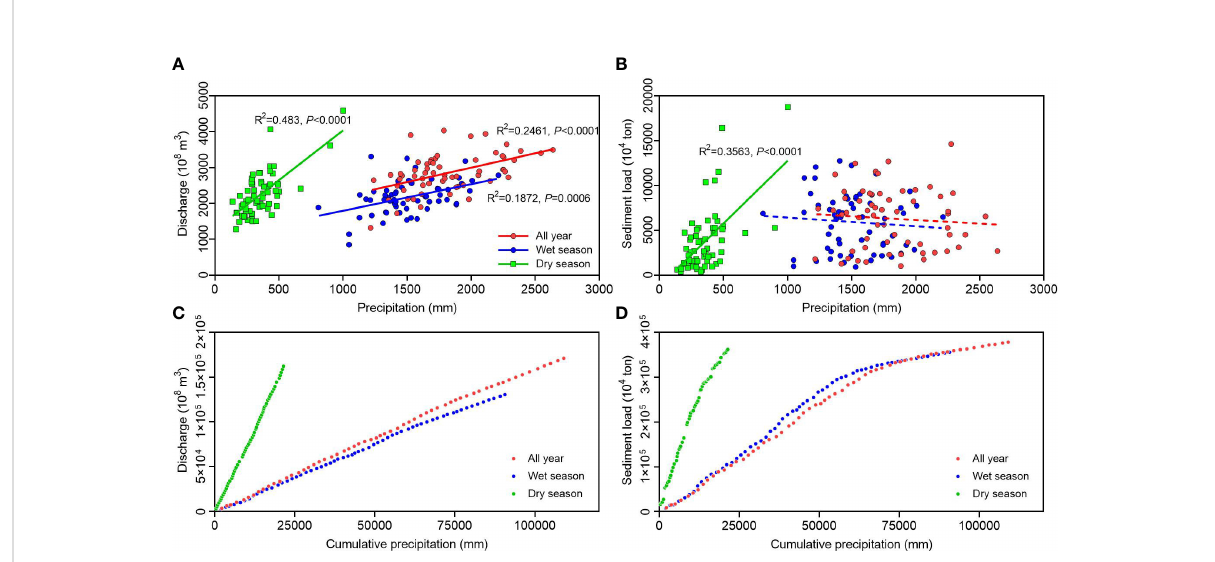
FIGURE 8 Correlation between annual and seasonal precipitation and discharge (A) , sediment load (B) in the Pearl River from the 1960s to the 2010s. Solid lines denote signi fi cant correlations ( P < 0.05), whereas dotted lines denote non-signi fi cant correlations. Plots of cumulative annual and seasonal precipitation versus cumulative discharge (C) , and cumulative sediment load (D) in the Pearl River from the 1960s to the